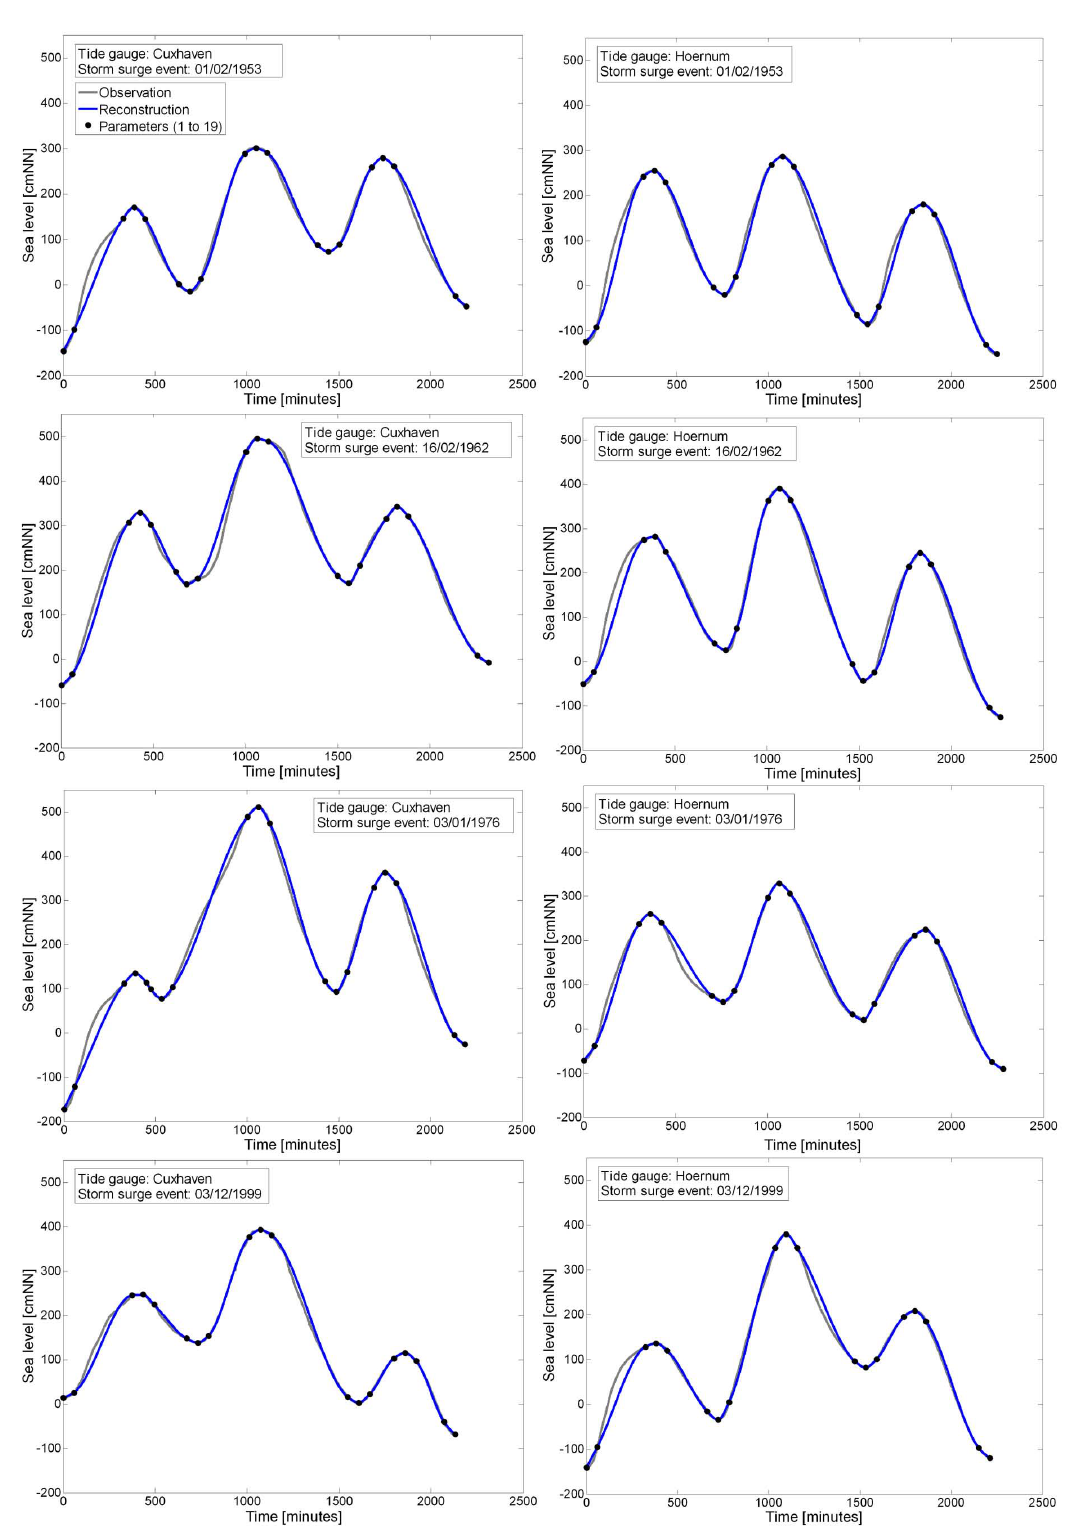
Fig. 8. Results from parameterising and reconstructing selected storm surge events observed at the tide gauges of Cuxhaven (left) and H¨ornum